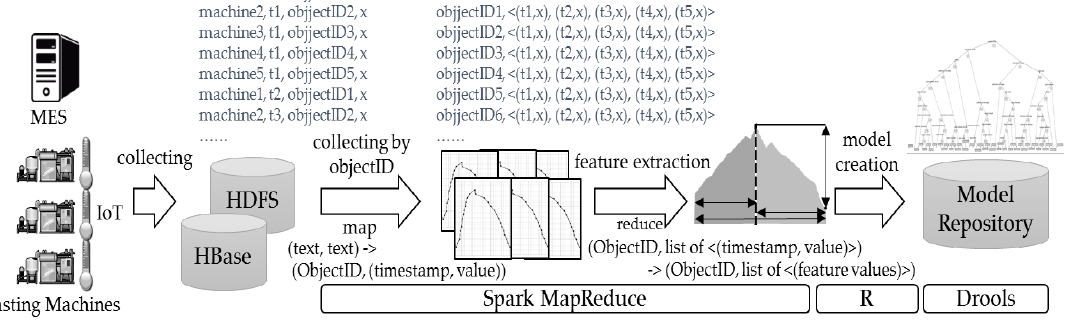
Figure 5. Example of MapReduce.